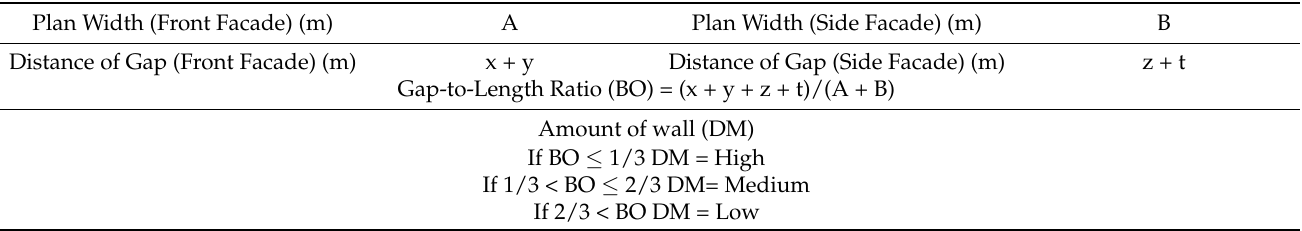
Table 7. Parameters for calculating the wall